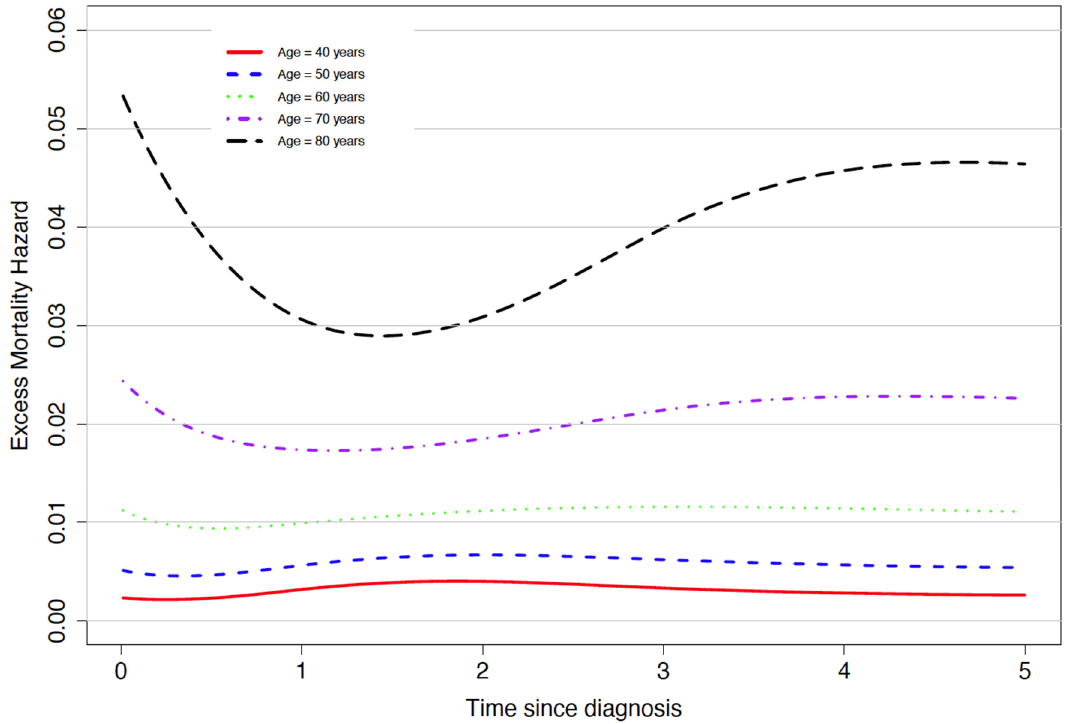
Figure A2. Excess mortality hazard (i.e., white males, least deprived, no comorbidities, diagnosed through general practitioner referral within an average LSOA (random effect of zero)) over time since diagnosis, for different ages, amongst those diagnosed with follicular lymphoma ( n = 15,516) in England during 2005–2013.